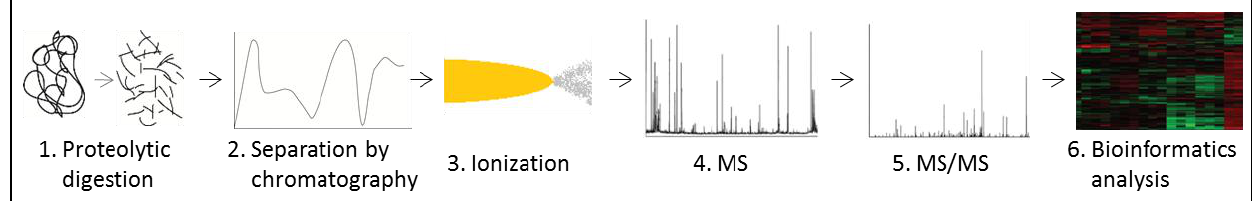
ratio ( m/z ) is measured in an initial scan ( 4 ). To identify the amino acid sequence, peptides are selected for fragmentation and subjected to MS/MS ( 5 ). Finally, bioinformatics tools are used to identify and/or quantify the proteins in the sample ( 6